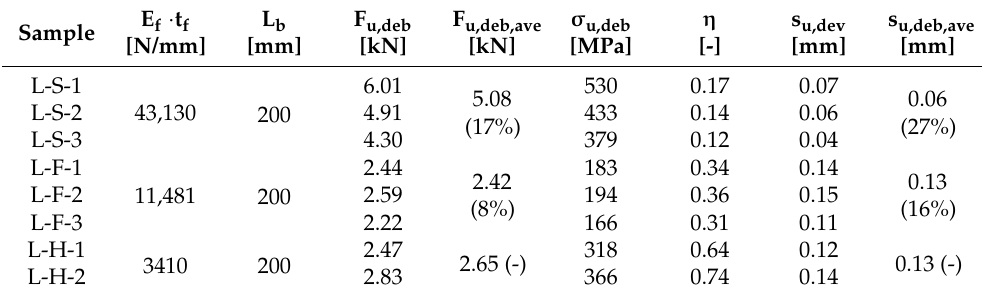
Table 7. Experimental results: stone unit—SFRP, HFRP, and